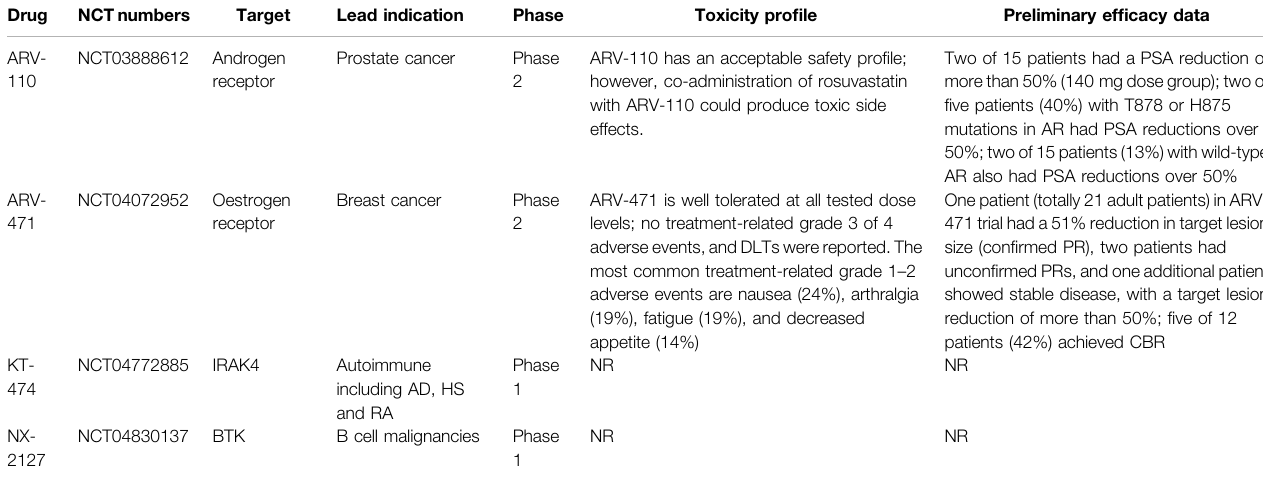
TABLE 2 | PROTACs in clinical